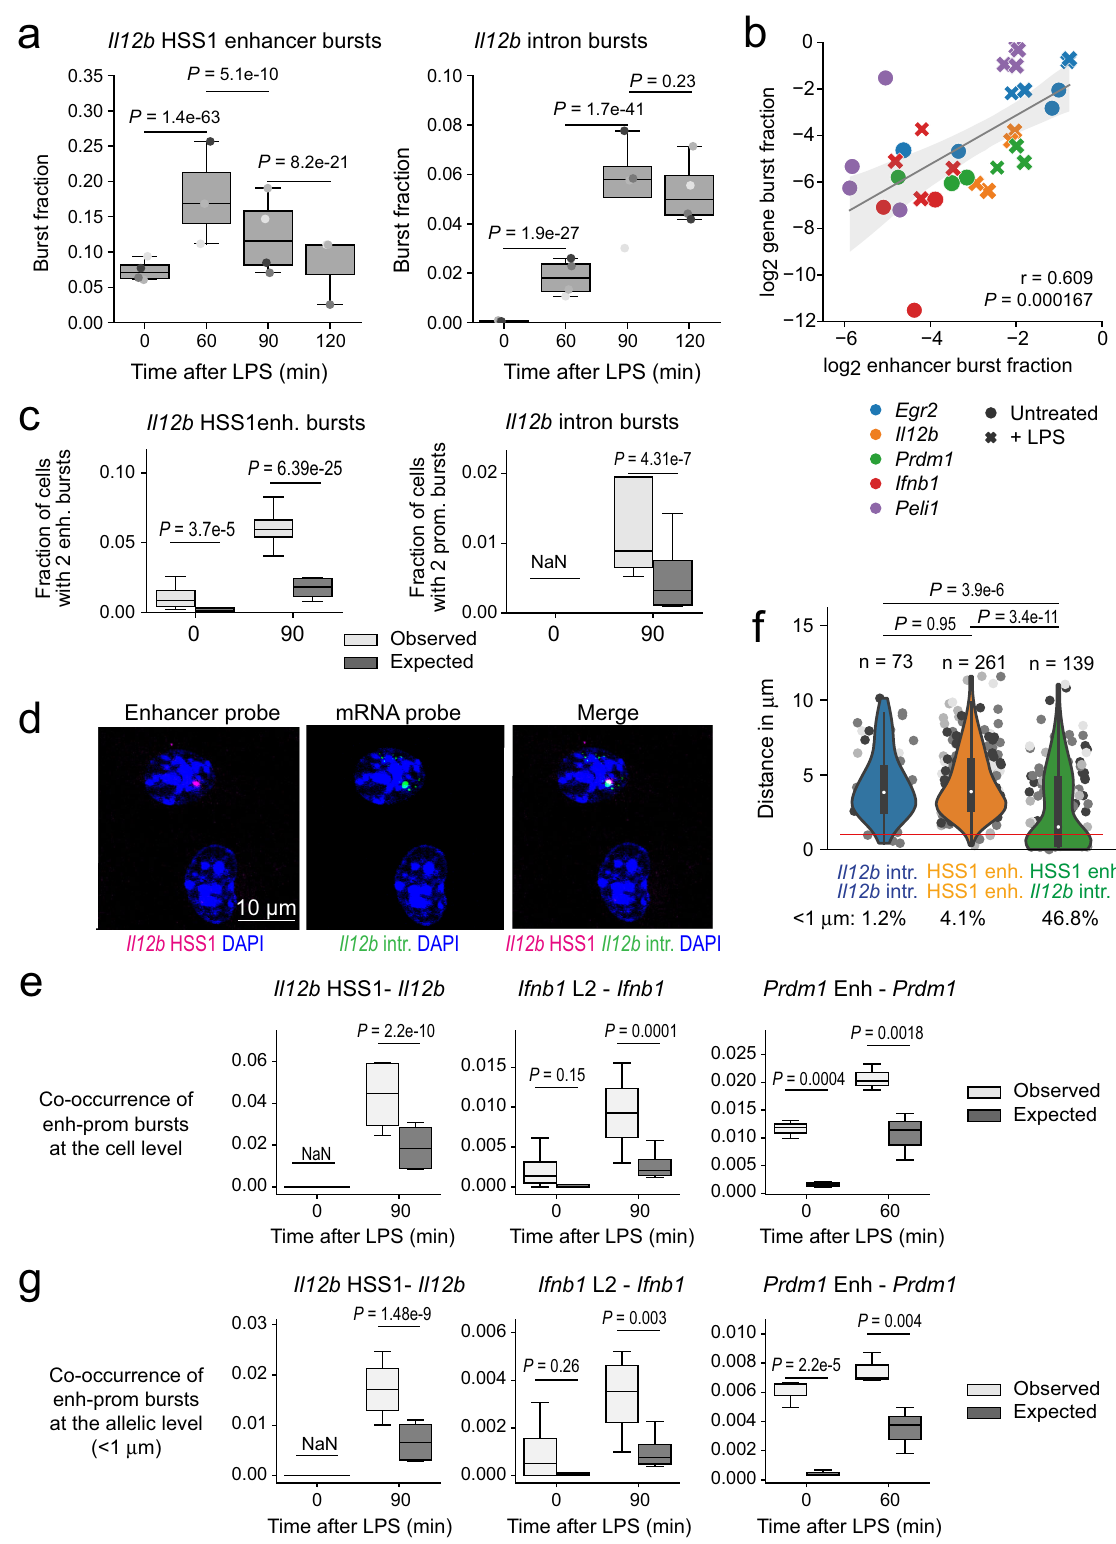
Prdm1 and Peli1 were markedly reduced in Rad21 − / − compared to wild-type macrophages (Fig. 7b). The promoter burst fraction of Egr2 was more strongly reduced than the Egr2 enhancer burst fraction in Rad21 − / − macrophages. To quantify the observed defects in promoter activation we analysed the relationship between transcriptional burst